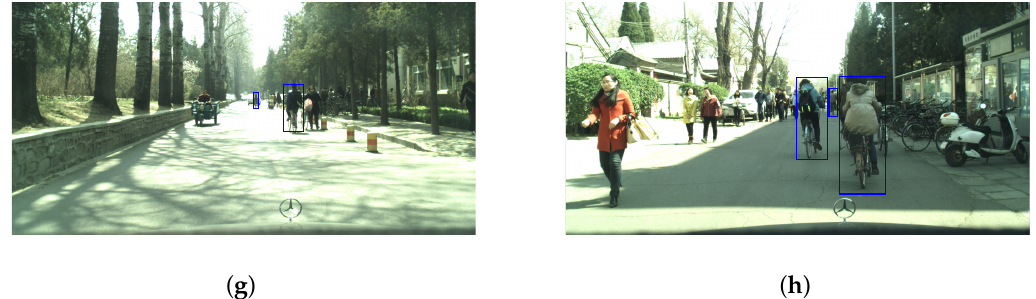
Figure 8. Some results of performing our detector on “Tsinghua-Daimler Cyclist Benchmark” with different scenarios. The images from ( a ) to ( h ) are the detection results in complex environments. In order to have a better visual effect, the contrast and brightness of the images above are enhanced for display. Blue bounding boxes represent detected